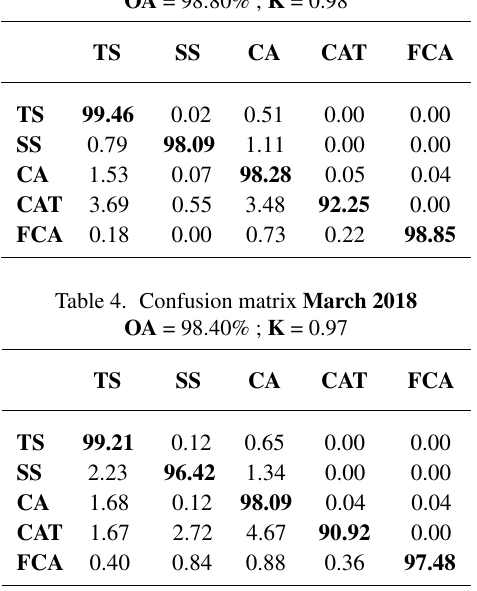
Table 3. Confusion matrix February 2018